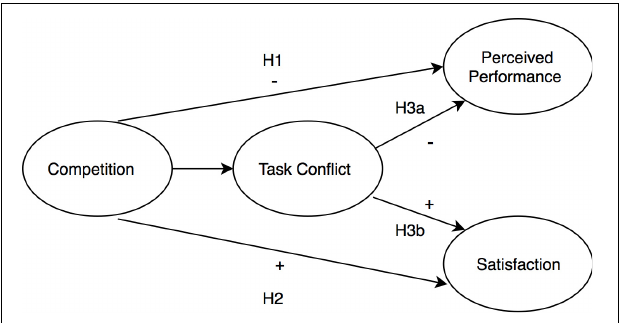
FIGURE 1 | Hypothesized model of proposed direct and indirect effects of competition on perceived performance and team satisfaction.